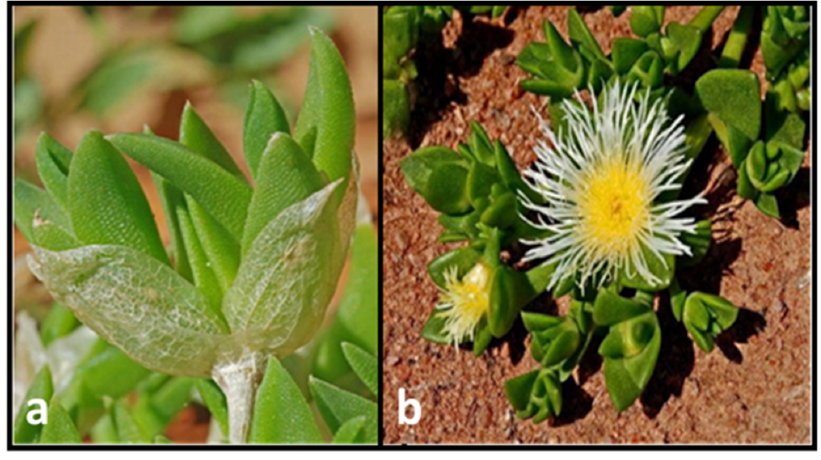
Figure 2. Dried out leaves of Sceletium tortuosum ( a ) and bright yellow flowering plant ( b )